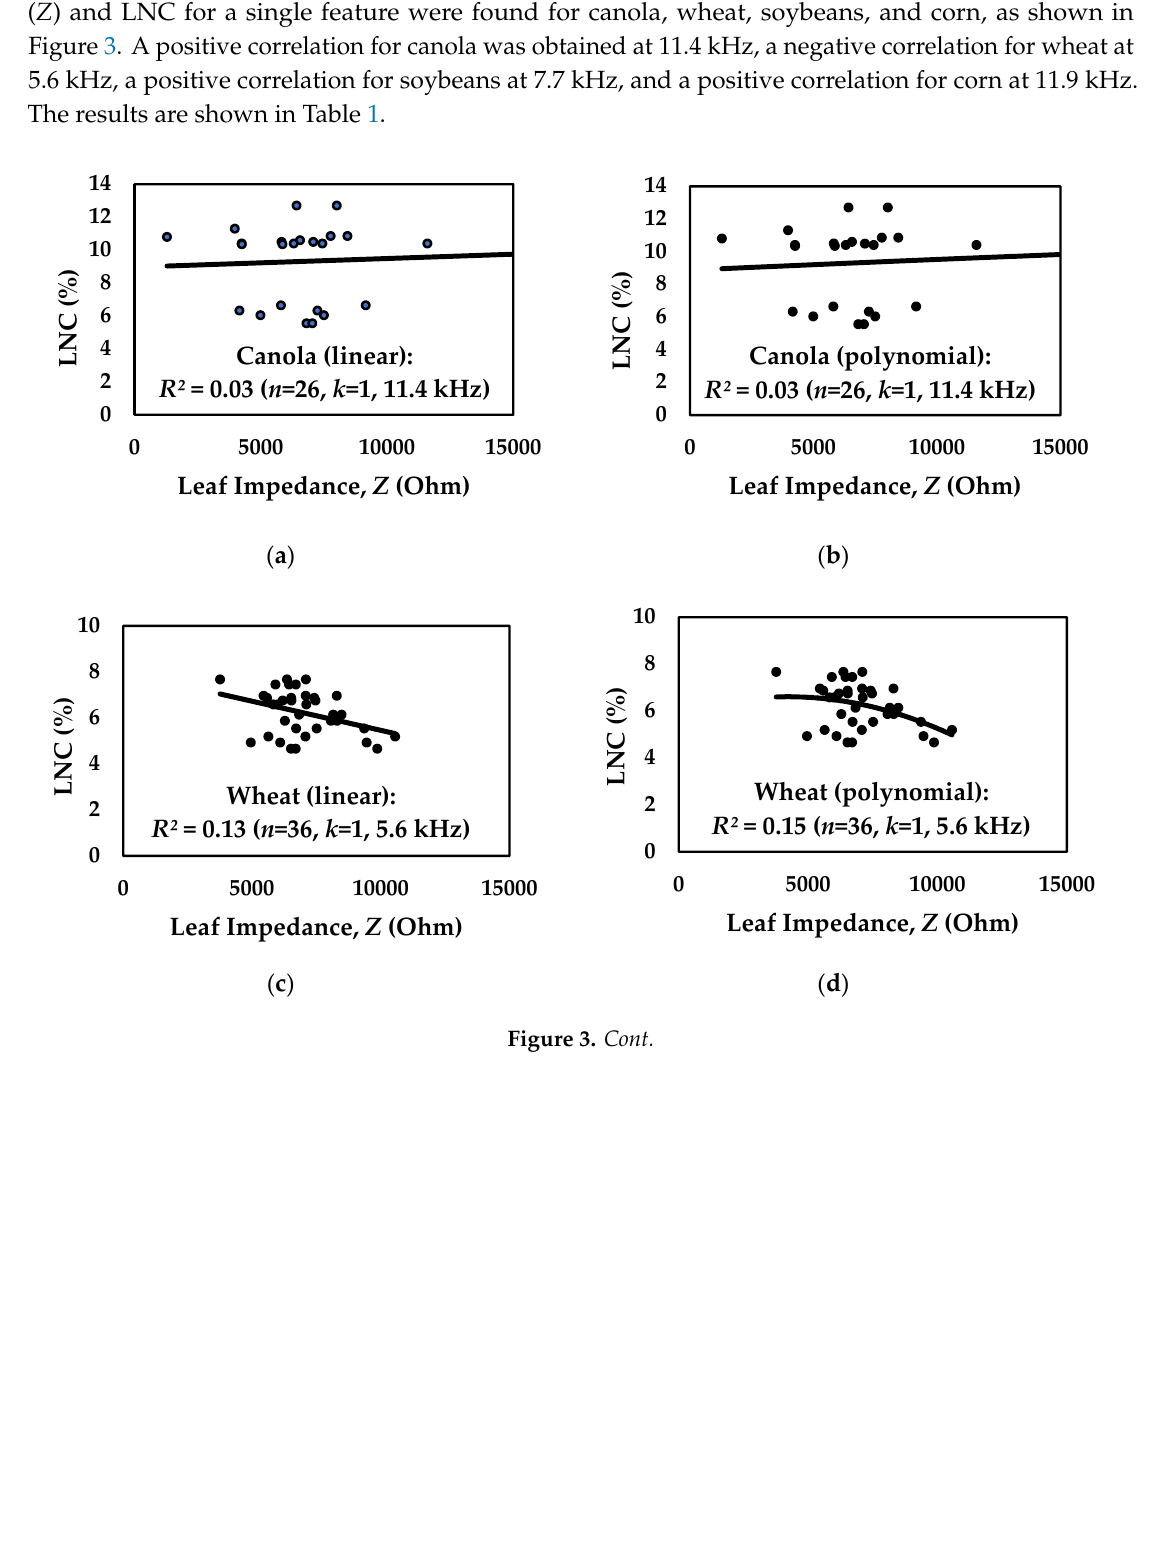
Figure 2. Plots of frequency versus leaf impedance. ( a ) canola; ( b ) wheat; ( c ) soybeans; and ( d ) corn at different nitrogen fertilization levels. The impedance profile for a few samples of wheat and soybeans could not be taken because of the effects of high nitrogen fertilization.